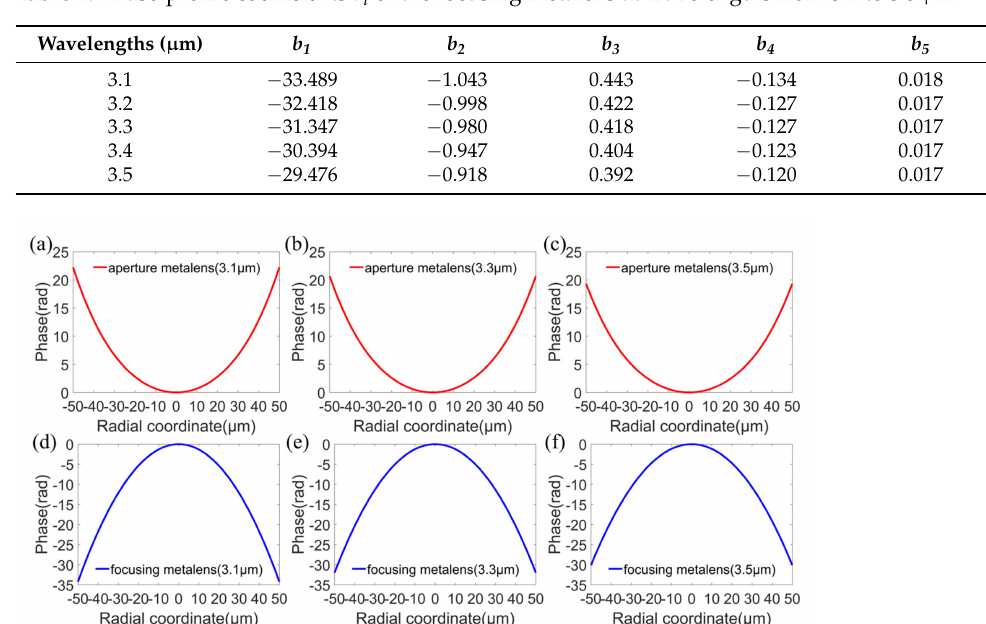
Table 2. Phase-profile coefficients b i of the focusing metalens at wavelengths from 3.1 to 3.5 µ m.